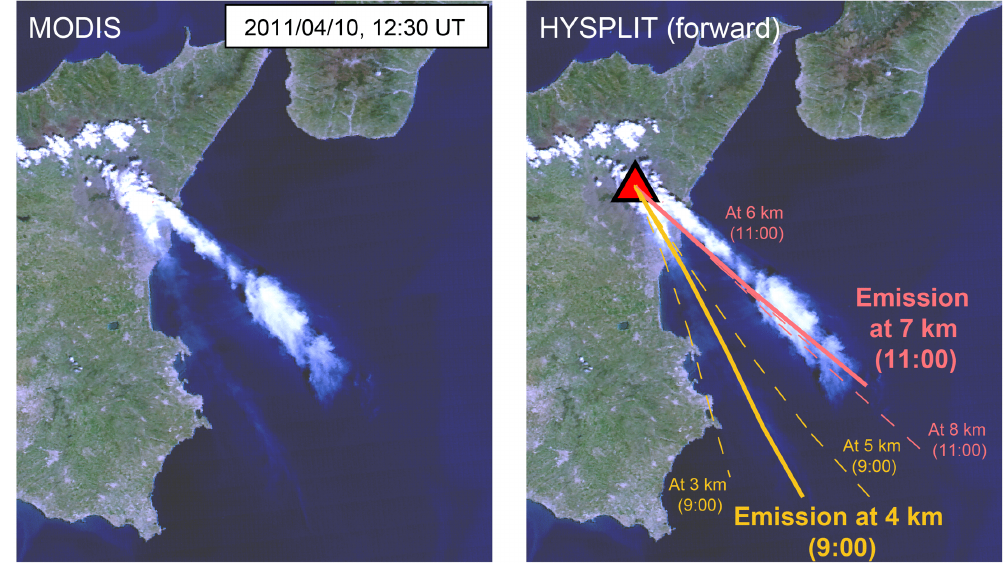
Figure 5. (Left) MODIS/AQUA RGB image of Etna plumes on 10 April 2011 at 12:30UT obtained from visible channels. (Right) Same as left panel, overlaid with the forward trajectories from the Lagrangian HYSPLIT model initialized with (yellow line) an emission at 4 ± 1kma . s . l . starting at 09:00UT and (pink line) an emission at 7 ± 1kma . s . l . starting at 11:00UT in agreement with the modelled source term with the inversion procedure (same colour code as in Fig. 3). Trajectories are computed until